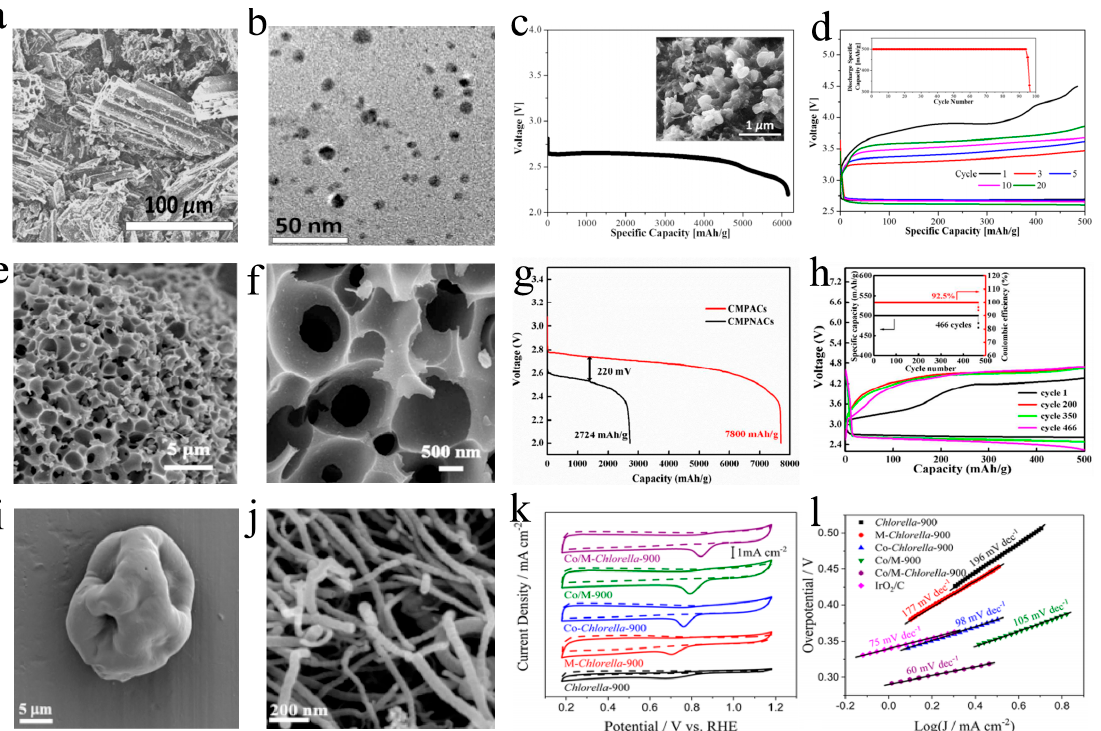
Figure 5. Biochars supported with catalyst being cathode materials for metal–air batteries; SEM image of biochars, electrochemical performance curves. ( a – d ) Sugarcane. Adapted with permission from ref. [100]. Copyright 2017, American Chemical Society. ( e – h ) Pomelo peel. Adapted with